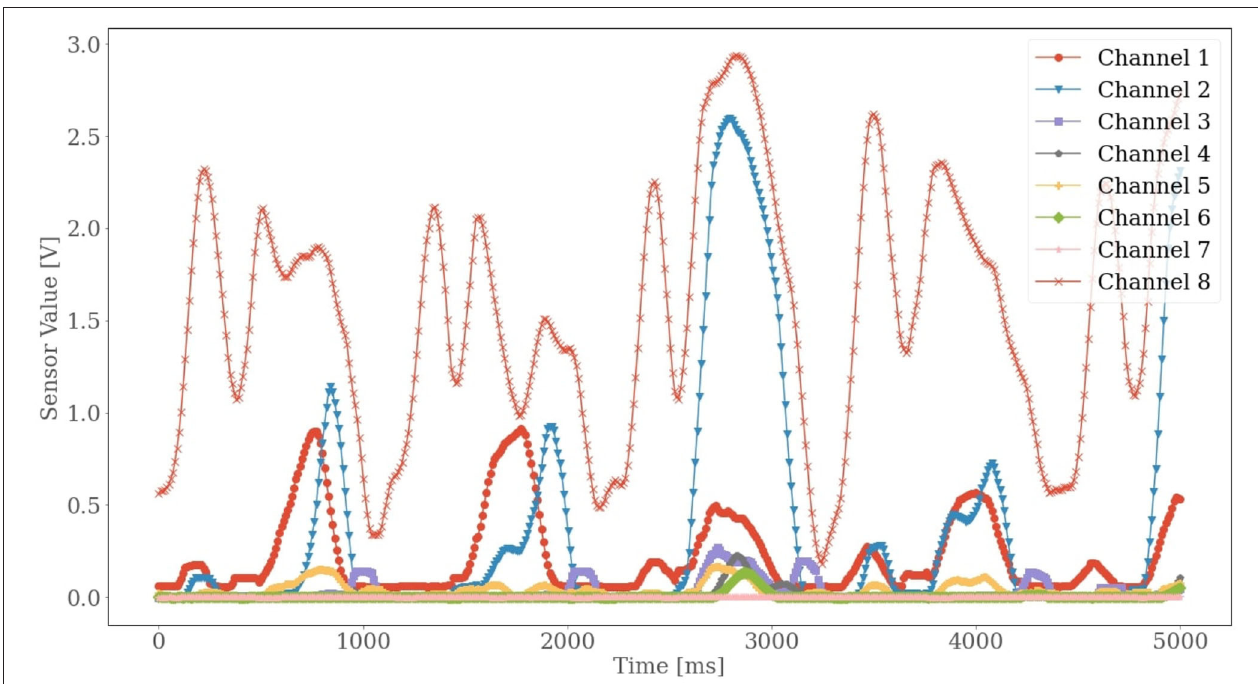
FIGURE 8 | Smoothed sensor values for subject 2 for the velocity of 1.6